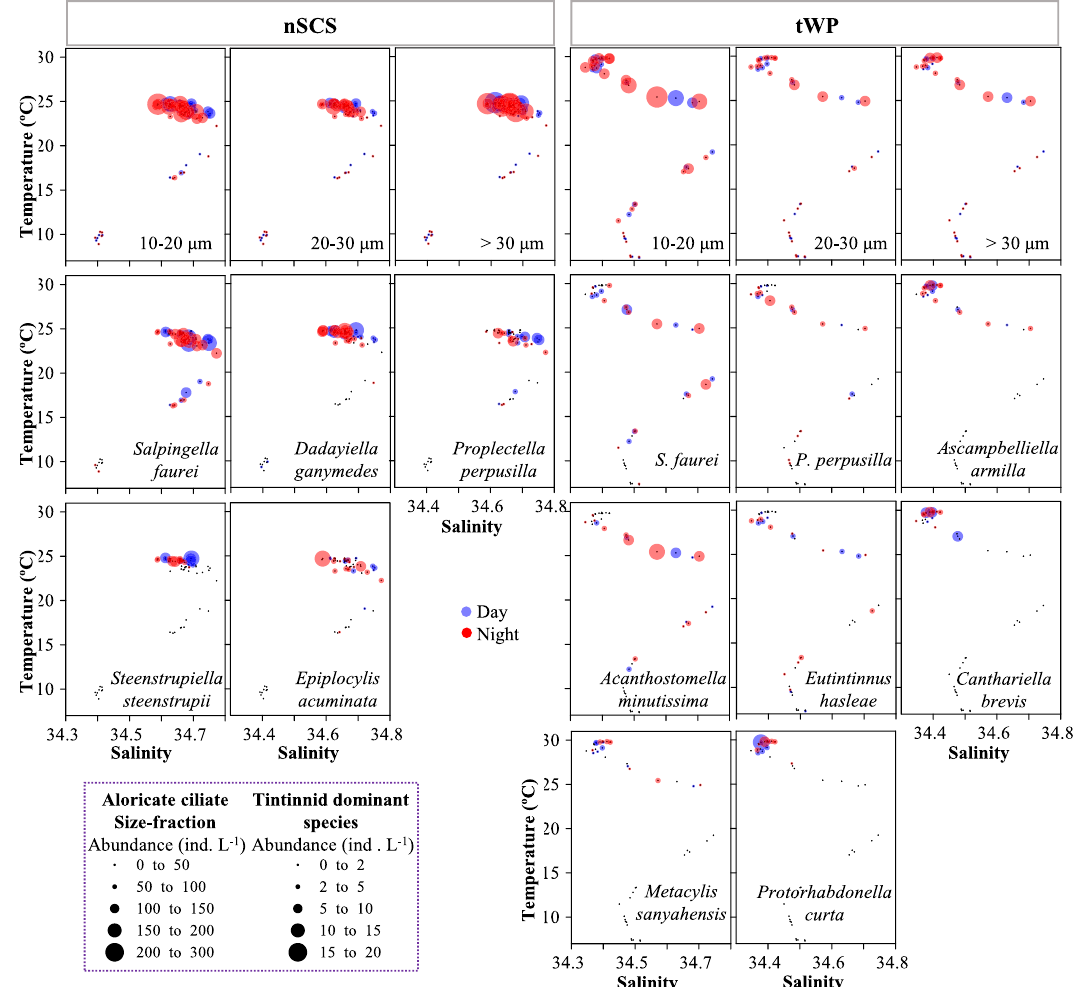
Figure 6. Temperature-salinity-plankton diagrams for day-night variations of size-fractions (10–20 μm, 20–30 μm and > 30 μm) of aloricate ciliate and tintinnid dominant species in the nSCS and